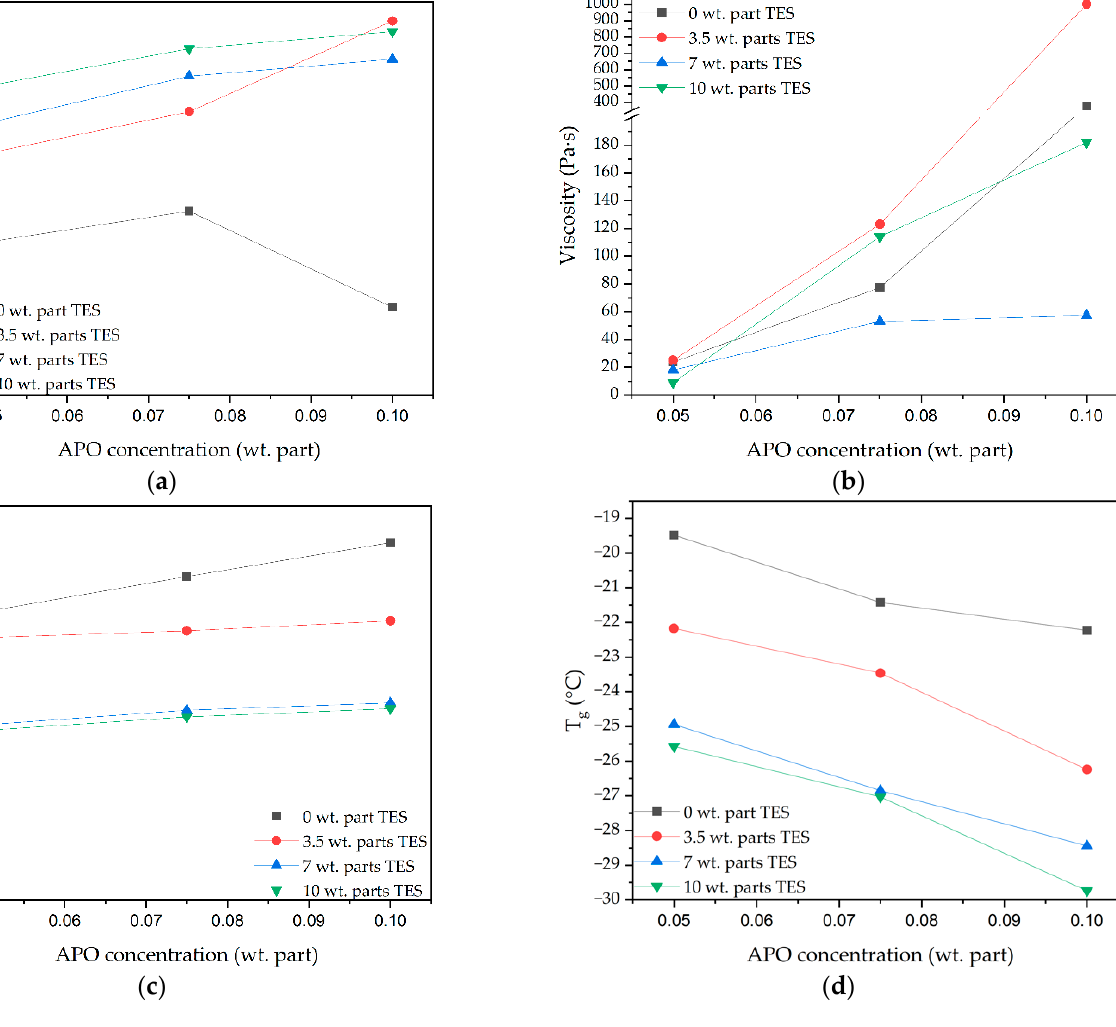
Figure 5. Solid content ( a ) and dynamic viscosity ( b ) of syrups and K-values ( c ) and T g ( d ) of silicone- (meth)acrylate telomers and (meth)acrylate copolymers. silicone-(meth)acrylate telomers and (meth)acrylate